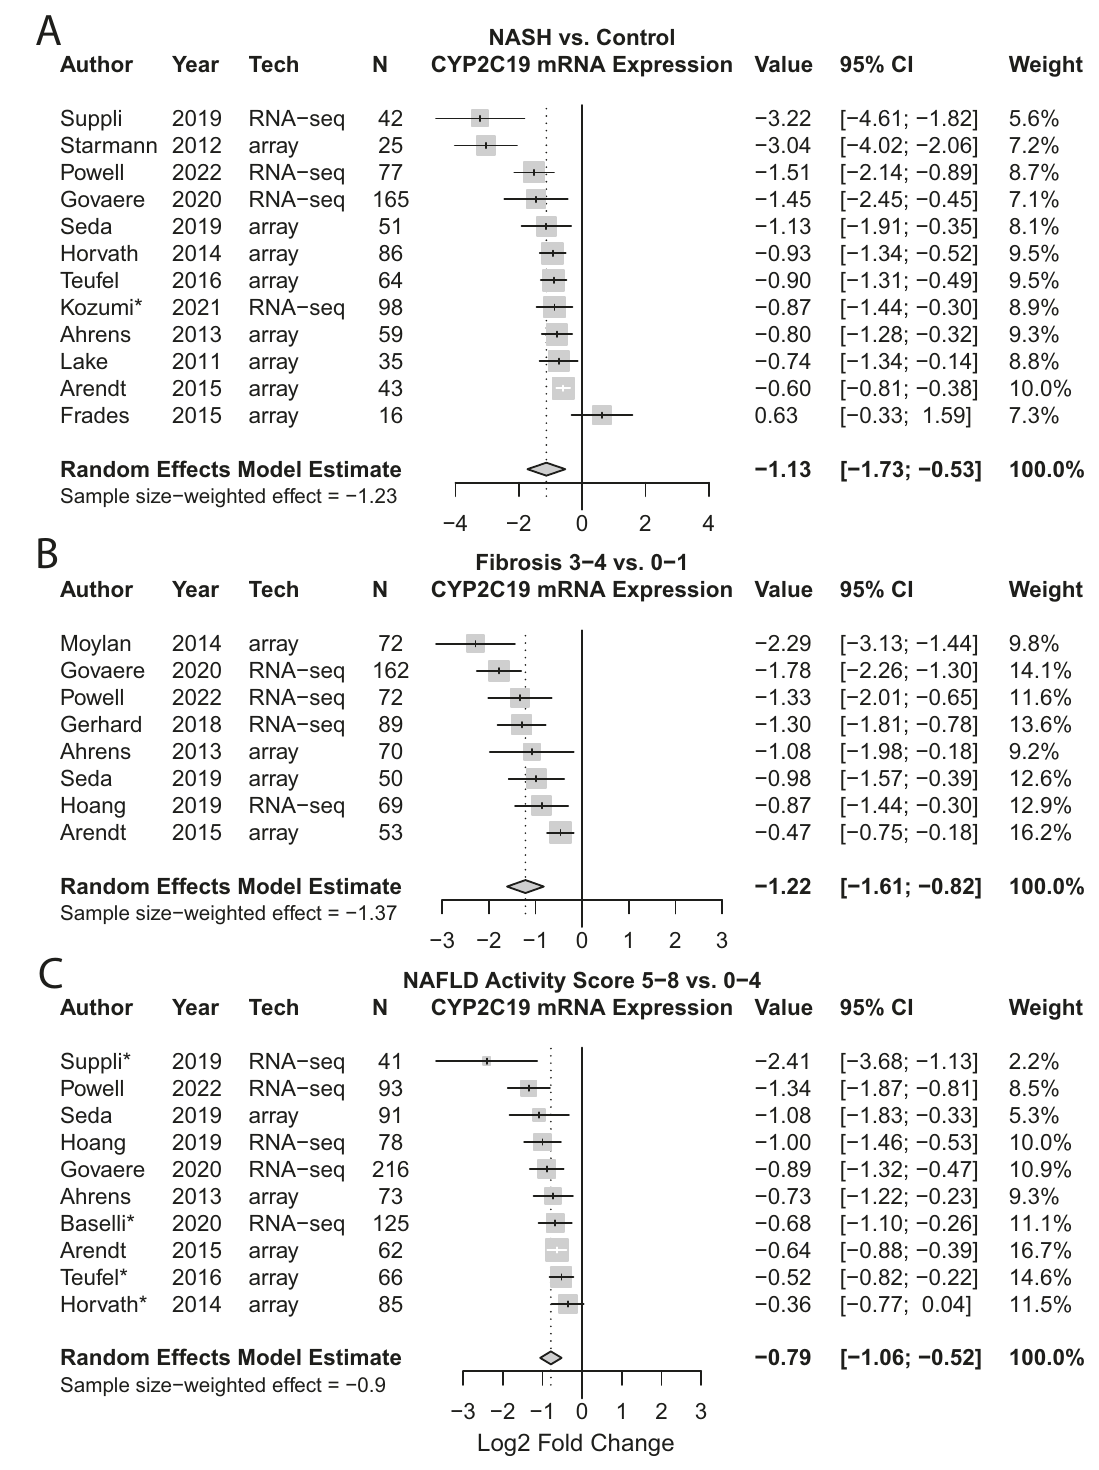
Fig. 6 | Forest plots demonstrating the meta-analysis effect of NAFLD on CYP2C19 mRNAexpression. Randomeffectsmodelestimates,weightedbasedon inversevariance,areprovidedinbold.Samplesize-weightedestimates(effects)are also provided. A NASHvs. no-NASH control. Note,studiesmarkedwith anasterisk (*) did not have a healthy control group, therefore subjects labelled “ NAFL ” were used as the comparator. B Fibrosis 3-4 vs. 0-1. C NAS 5-8 vs. 0-4. Note, for studies